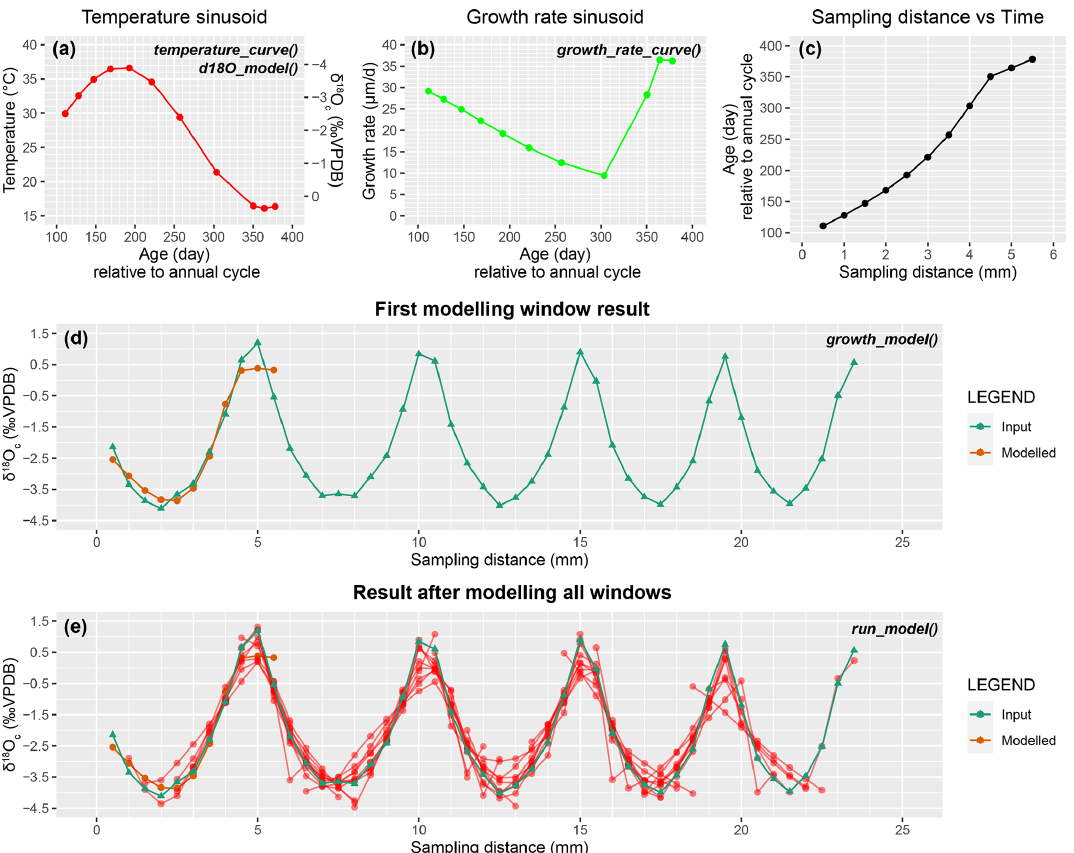
Figure 4. Showing the steps taken to simulate δ 18 O c data in the run_model function on the test case. (a) Temperature sinusoid used to approximate δ 18 O c data in the first modeling window (see panel d ), produced using a combination of temperature_curve and d18O_model functions. Symbols indicate the positions of δ 18 O c samples on the temperature curve, with estimated δ 18 O c values shown on the secondary axis (right). (b) Skewed growth rate sinusoid fit to the δ 18 O c data using the growth_rate_curve function. Note the shift towards steeper growth rate increase around the 300th model day (autumn season in this example). See Fig. S2 for a detailed description of the growth rate sinusoid. (c) The modeled age–distance relationship for this window after fitting δ 18 O c data, resulting from aligning the estimated age of samples ( x axes in panel a ) with the distance in sampling direction ( x axis in panel d ) using the cumulative growth rate function (b) . (d) δ 18 O c profile of the test case (green) with the δ 18 O c curve of the first modeling window (red), which results from the combination of temperature (a) and growth rate (b) sinusoids, plotted on top ( growth_model function). (e) Result after simulating the full δ 18 O c profile of the test case (green) using run_model , with the δ 18 O c curves of individual modeling windows shown in red.